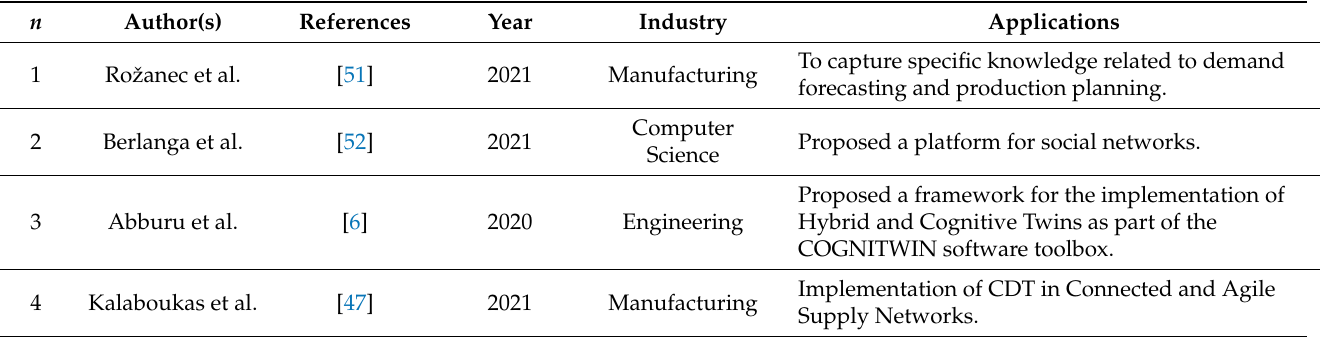
Table 2. Diverse Cognitive Digital Twins applications in various fields of industry.